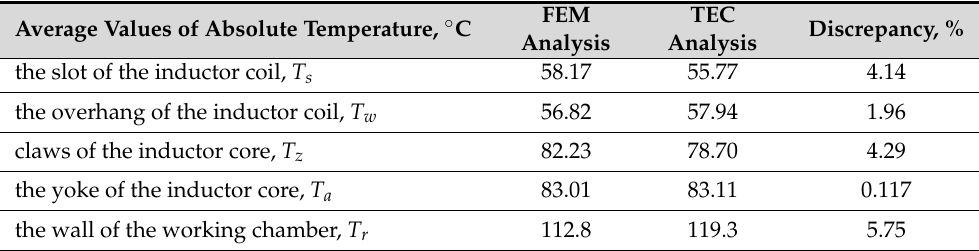
Table 2. The overview of the results obtained on the basis of FEM analysis and TEC analysis. Average Values of Absolute Temperature, ◦ C